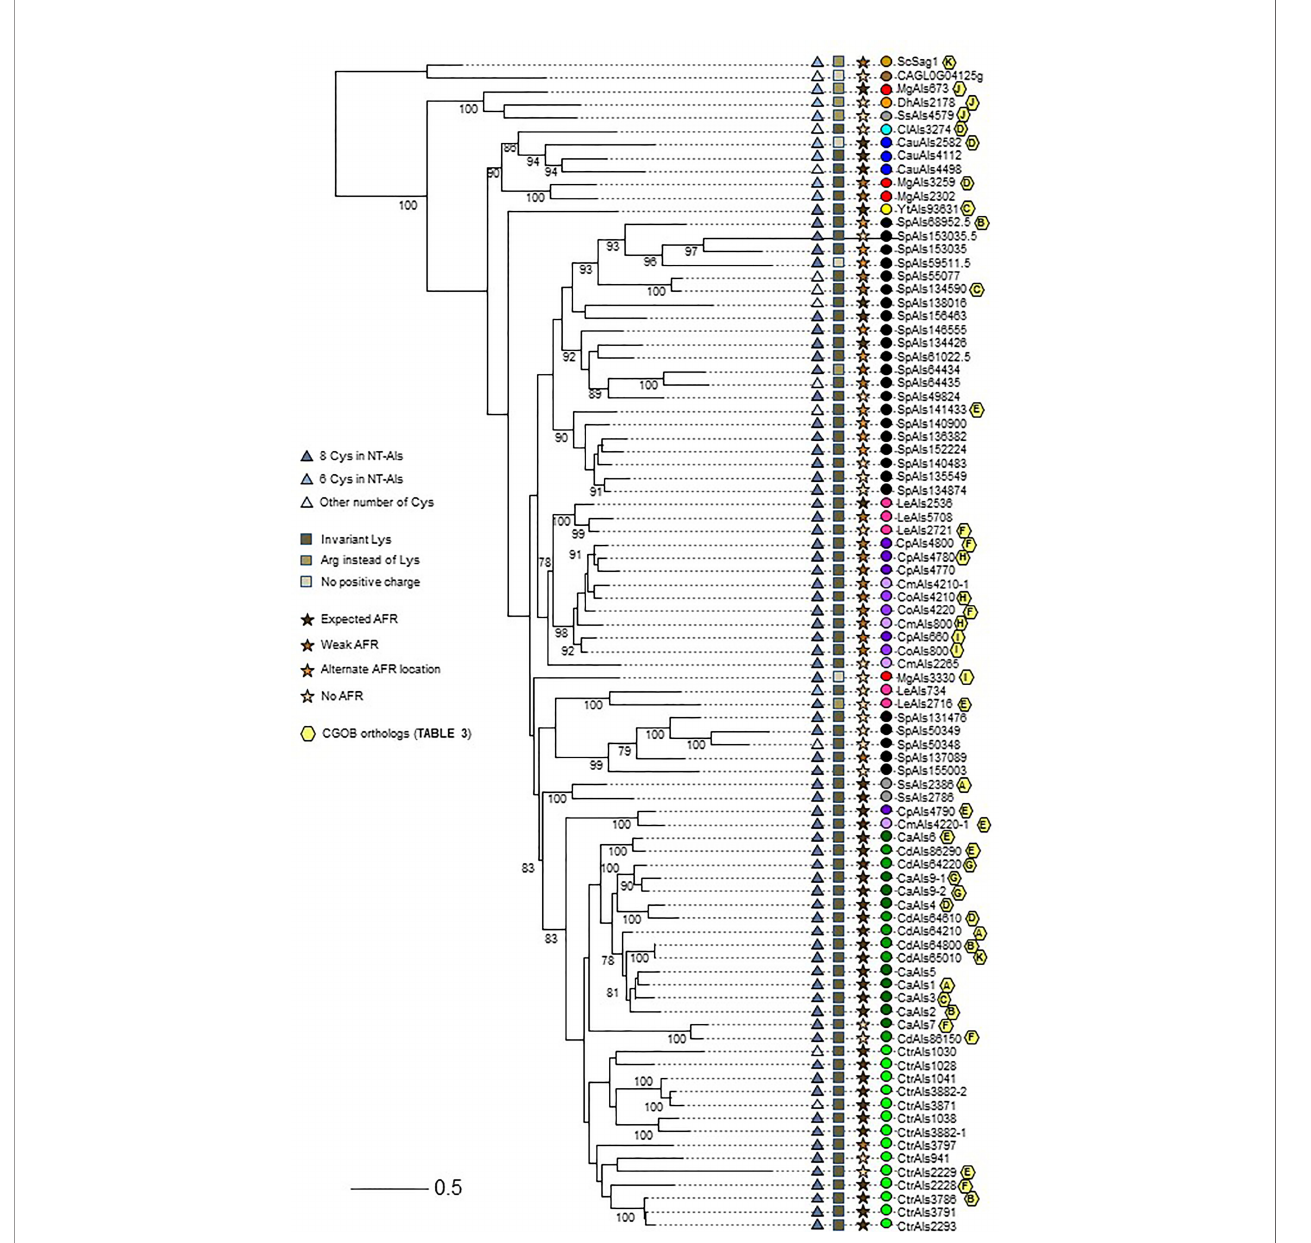
FIGURE 5 | Relationships between NT-Als sequences depicted in a tree format. Information from Figure 4 (number of Cys in NT-Als, presence of the invariant Lys, nature of the AFR) is included using symbols at the left of the tree. Yellow hexagons on the right of the branches depict ortholog group information from Table 3 . Colored dots indicating species follow the color scheme from Supplementary Table S2 and Figure 4 . The scale bar represents substitutions per